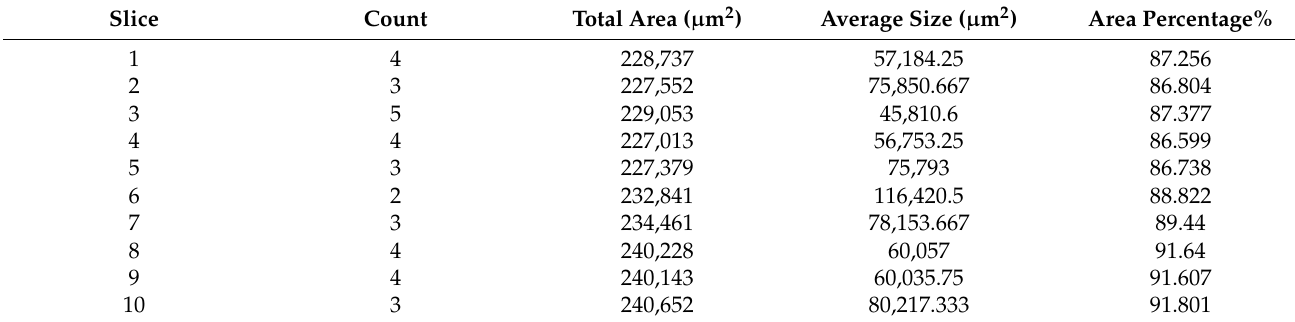
Table 5. Size analysis of segment 2 (mineral 2) in the segmented output.